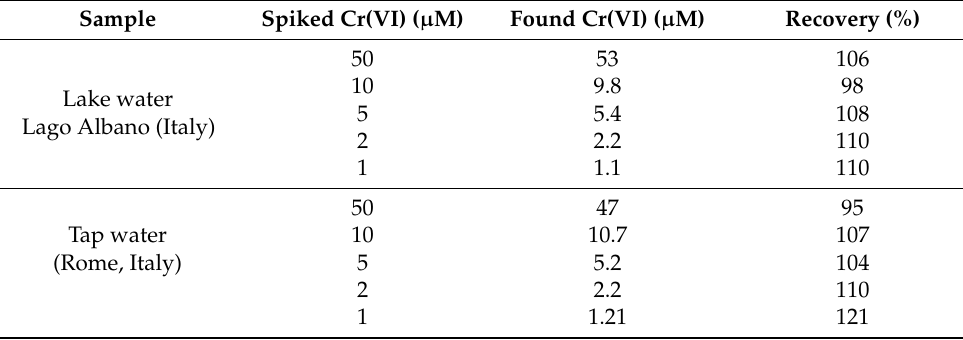
Table 2. The recovery of Cr(VI) ions in real lake and tap water